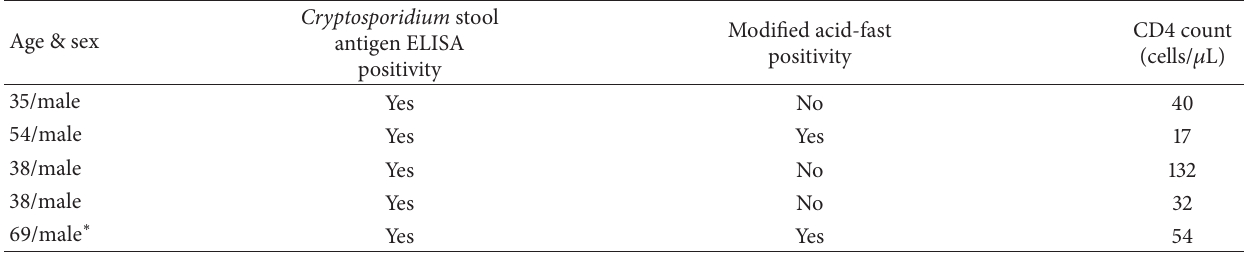
Table 2: Cryptosporidium positive